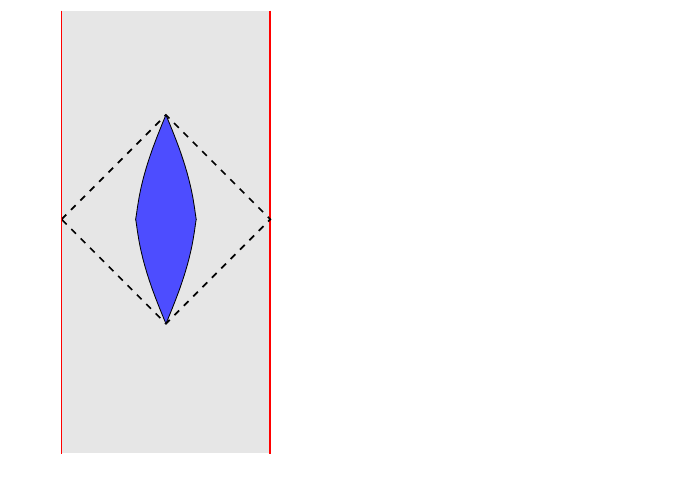
Figure 30 . Interval of (cid:12)xed width in Schwarzschild time (blue shaded region) in the BCFT world- volume